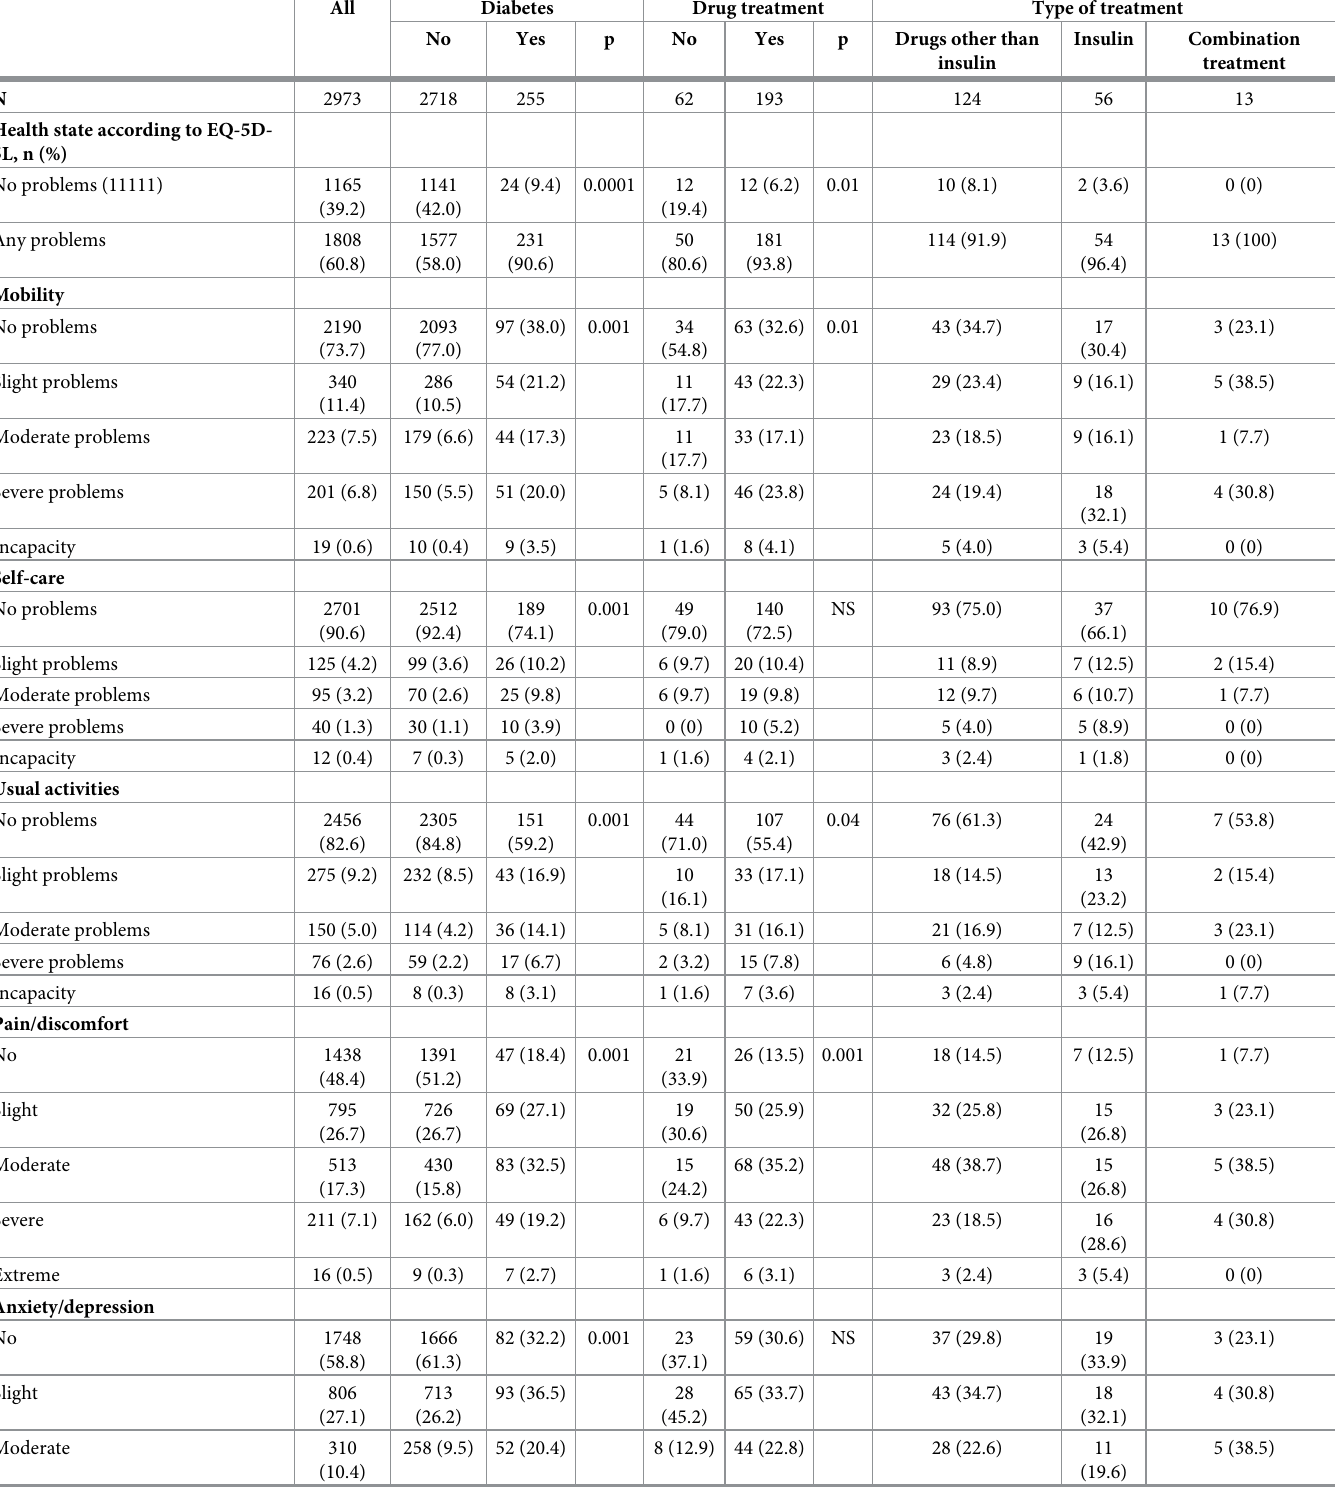
Table 2. Problems in EQ-5D-5L dimensions according to diabetes and treatment status, n (%). All Diabetes Drug treatment Type of